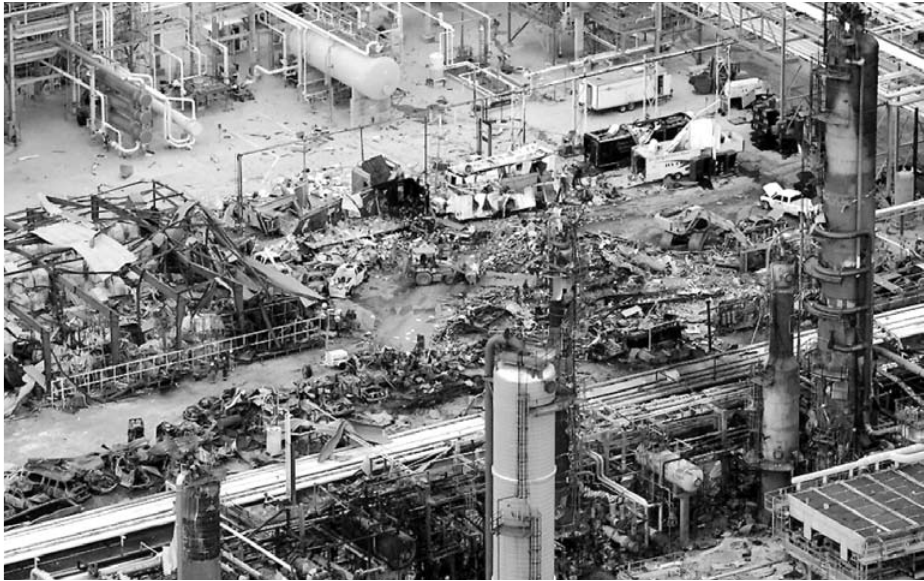
fig. 2. Explosive damage to the building with portal steel frames (at the middle-left side of the picture; BP Texas City explosion March 2005) (CSHIB